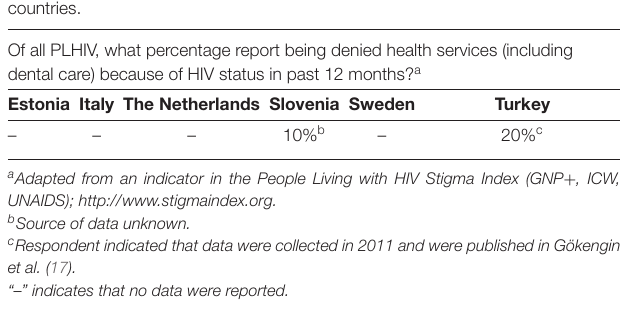
TABLE 5 | Discrimination against PLHIV within health systems in six European